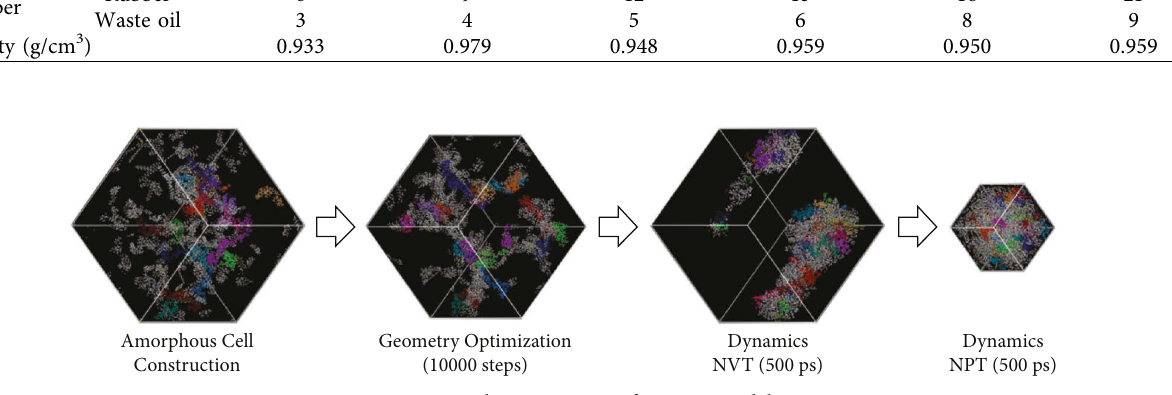
Figure 5: Simulation process of CRMA models.